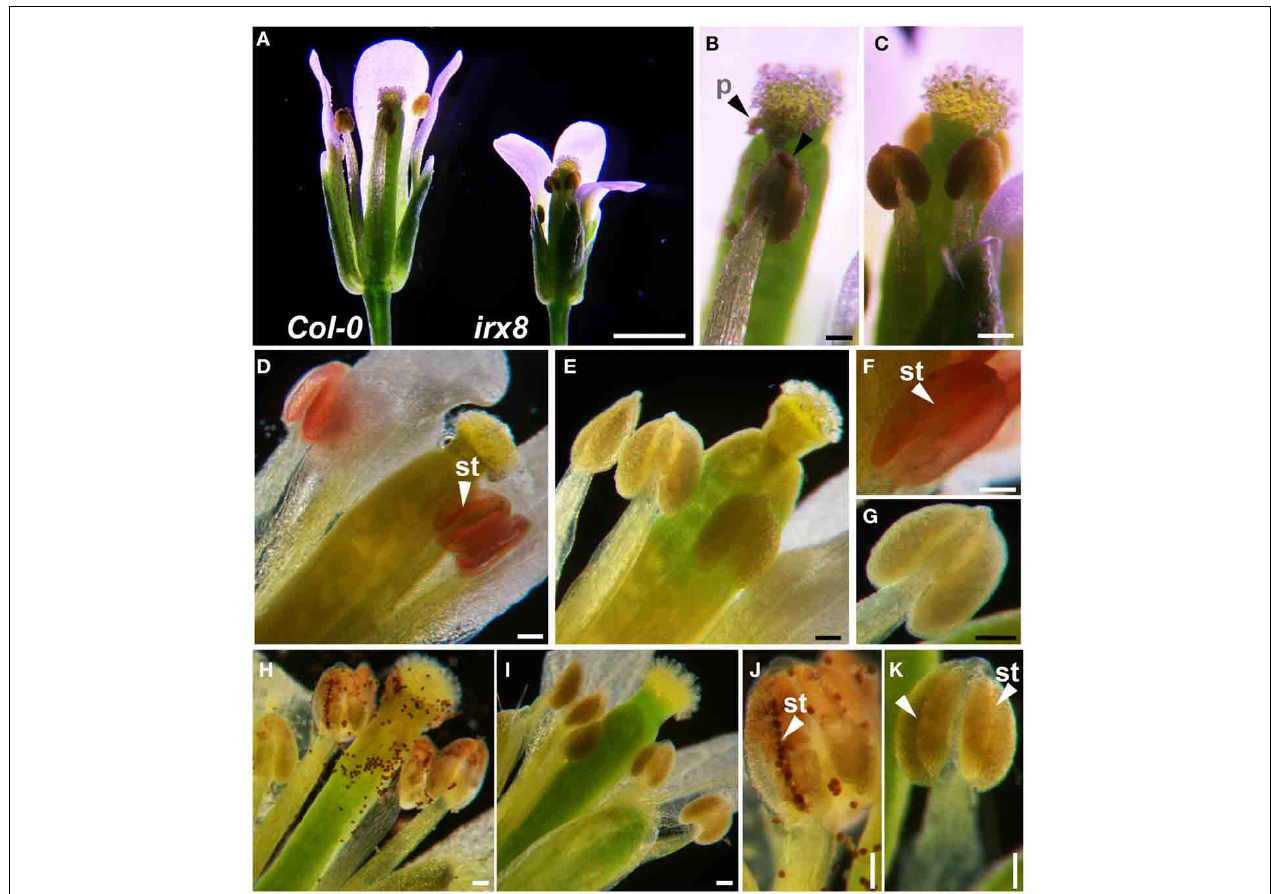
FIGURE 1 | Loss of lignin in anther endothecium cells results in failure of antherdehiscencein irx8 mutants.(A) Lightmicroscopeimagesofwild-type and irx8 open flowers (stage 13, anthesis). (B) Close-up of Col-0 pistil and anthers. (C) Close-up of irx8-5 pistil and anthers. (D–G) Red phloroglucinol-HCl staining of flower anther indicates presence of lignin. Endothecium layer stains red in wild type (D) , the lack of staining in irx8-5 (E) , close-up of a wild-type